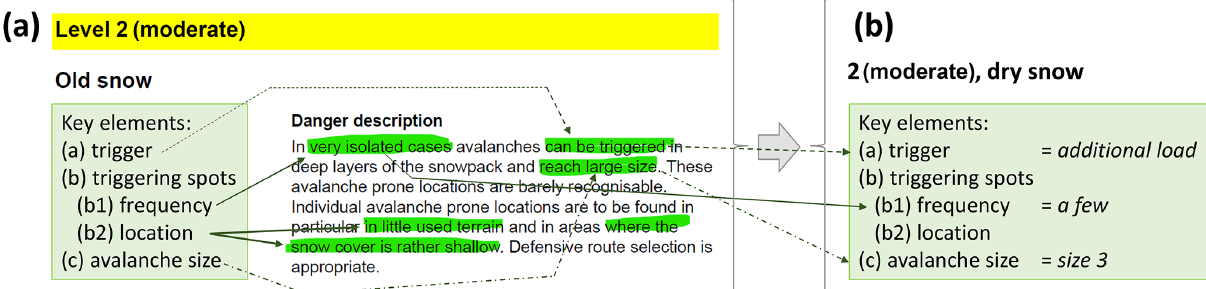
Figure 4. Following the annotation and labeling (Sects. 4.1 and 4.2), the key factors and their labels were extracted from each danger description. Here, the same example as used in Fig. 1b is